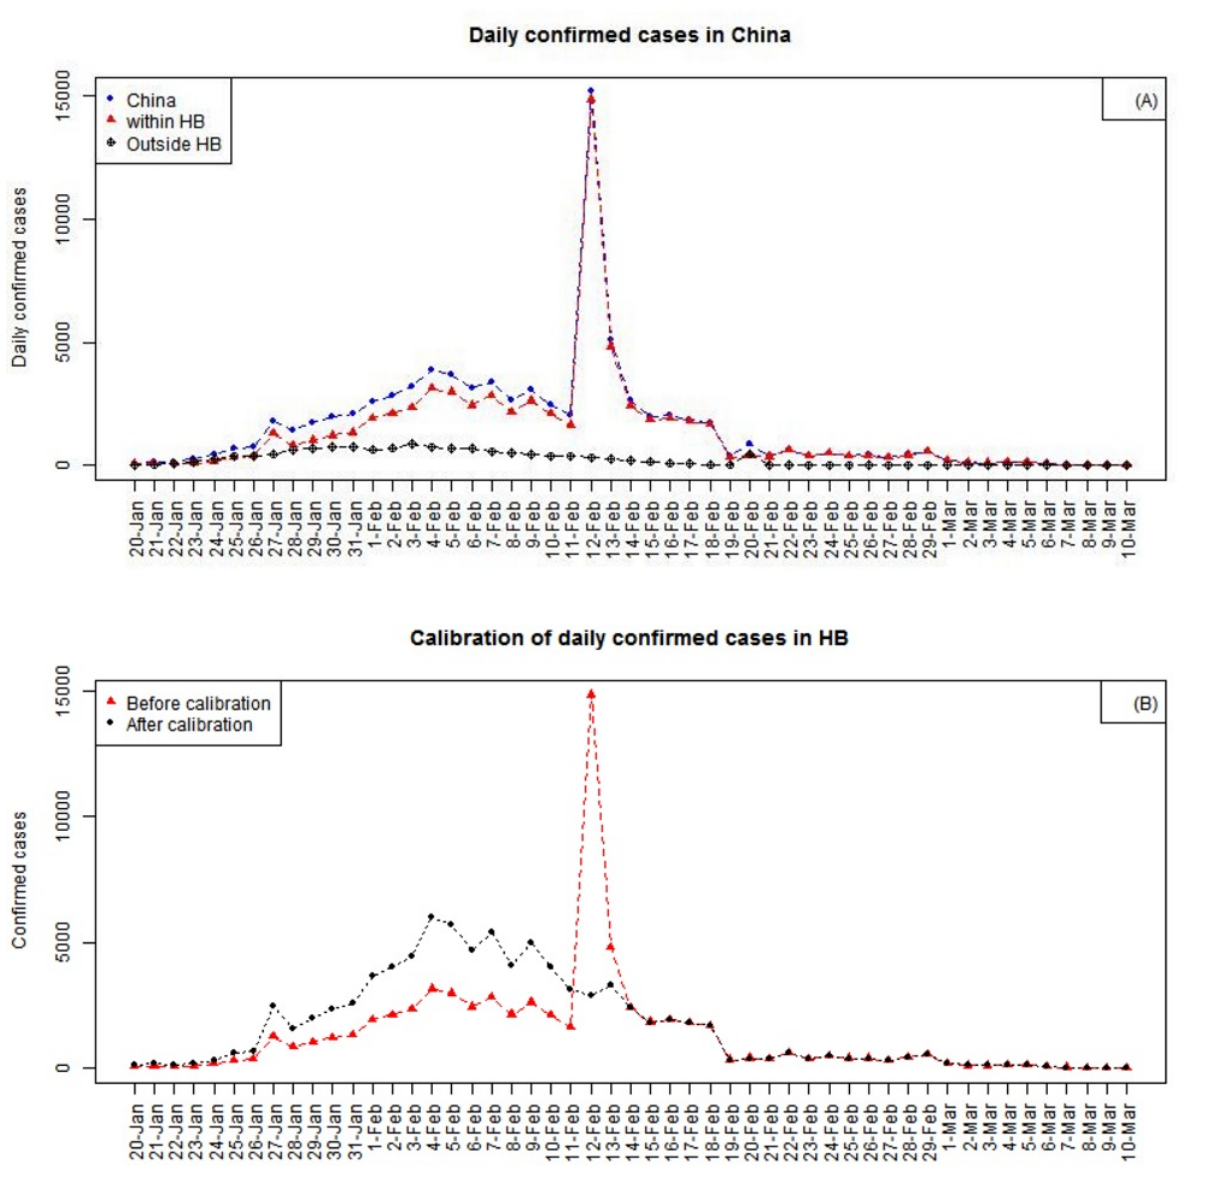
Figure 1. (A) Daily confirmed cases of COVID-19 in China. Blue dots represent numbers for the whole country, red triangles represent numbers for Hubei Province, and black circles represent numbers for other provinces. (B) Calibration of the daily number of confirmed cases in Hubei Province. Red triangles represent the daily number of confirmed cases in the province before calibration, and black dots represent the daily number of confirmed cases in the province after calibration. The sharp peak disappeared after calibration. HB: Hubei